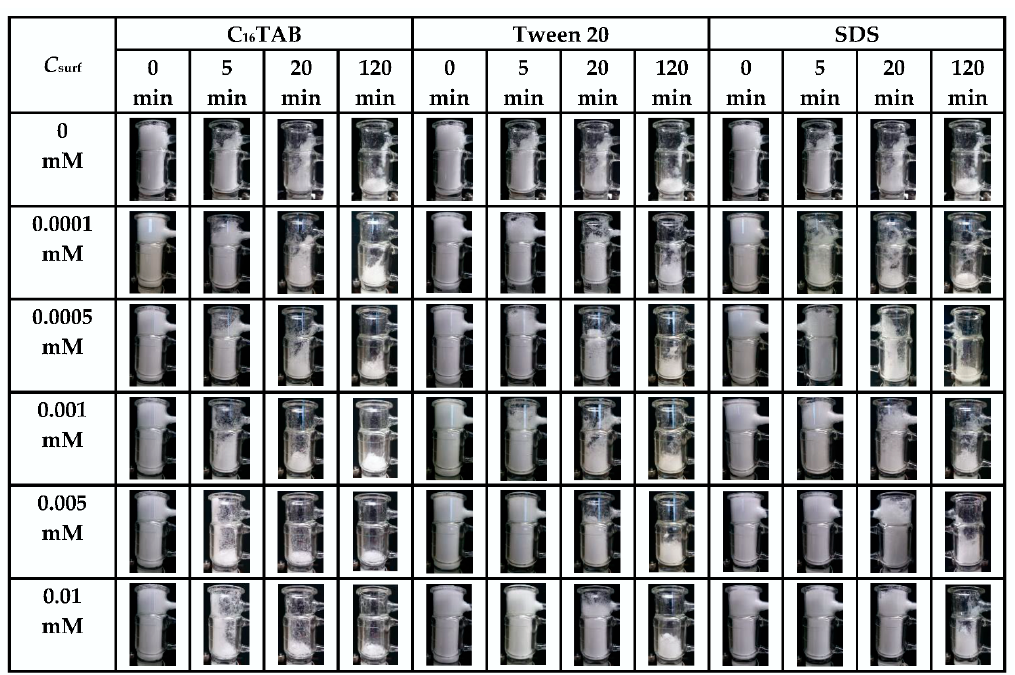
Figure 9. Digital photographs of foams fabricated from 0.2 mg/mL SF solutions in presence of different salt types and concentrations taken at various times after the foaming process was terminated (taken from [36]).